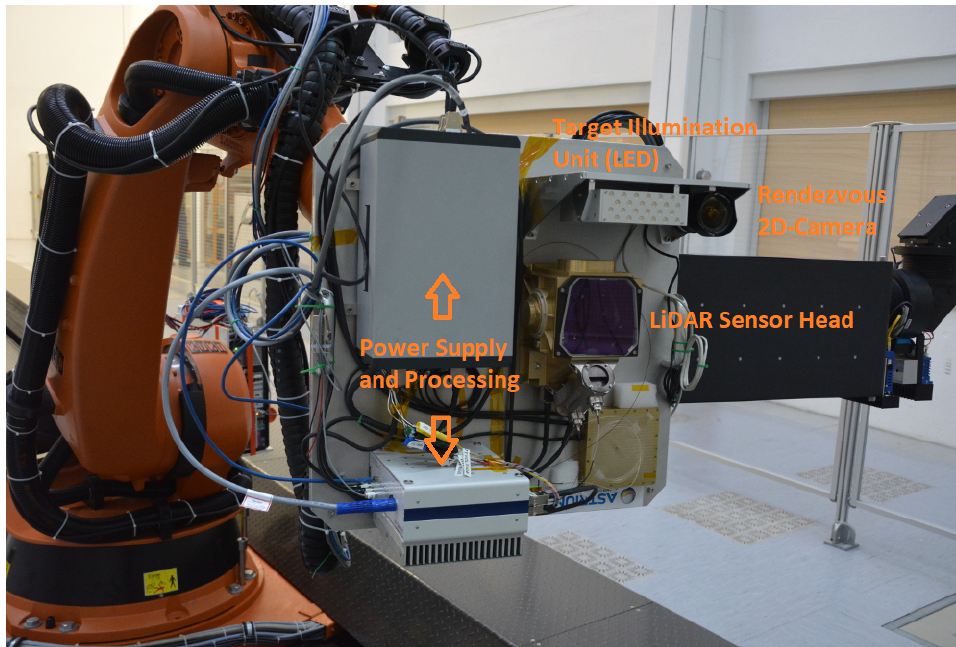
Figure 12. Sensor setup for the DEOS test